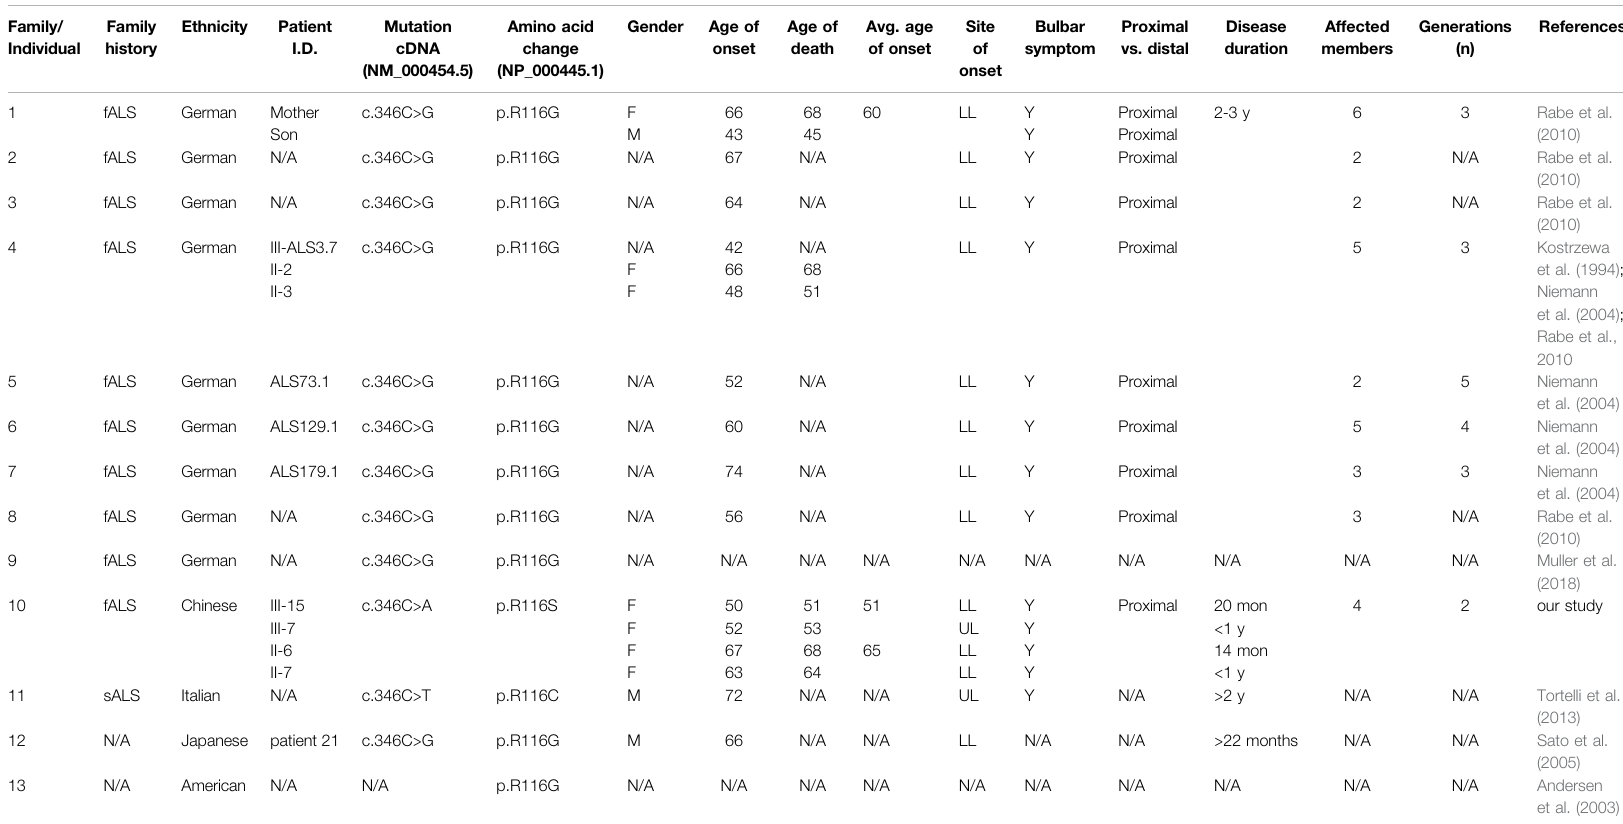
TABLE 2 | Clinical features of previously reported patients carrying SOD1 mutations of R116. The reference cDNA and protein sequences for mutations included in the table are NM_000454.5 and NP_000445.1. Family/